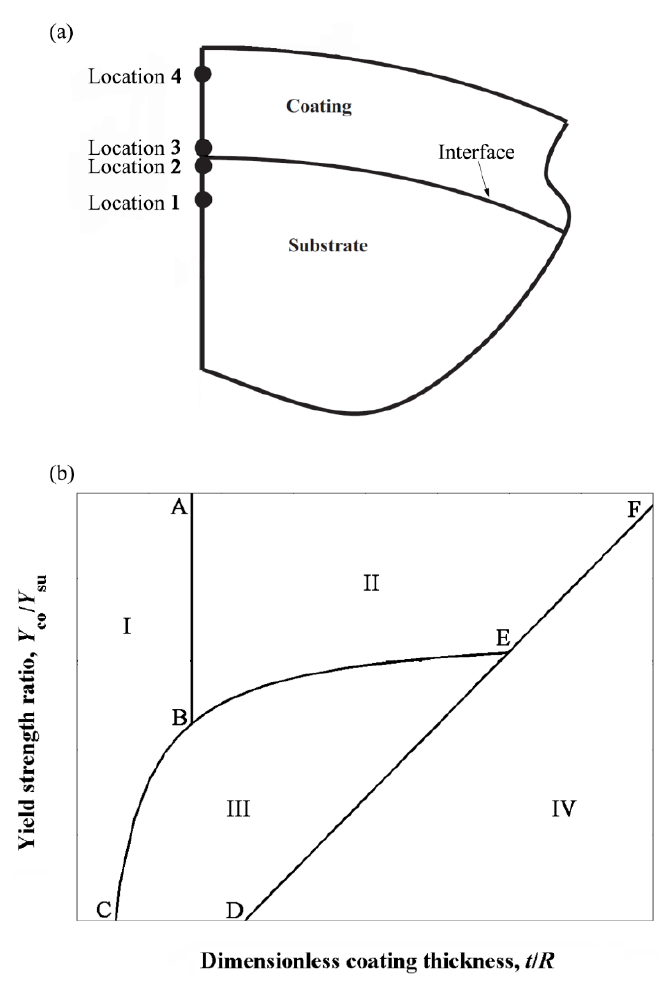
Figure 4. ( a ) Schematic of the tip of a coated sphere where the four possible locations of yield inception are shown and ( b ) a generic yield map presenting the yield inception location as a function of t / R and Y co / Y su , taken from [31]. Table 2. Physical meaning of t / R values on zone boundaries in the yield map.